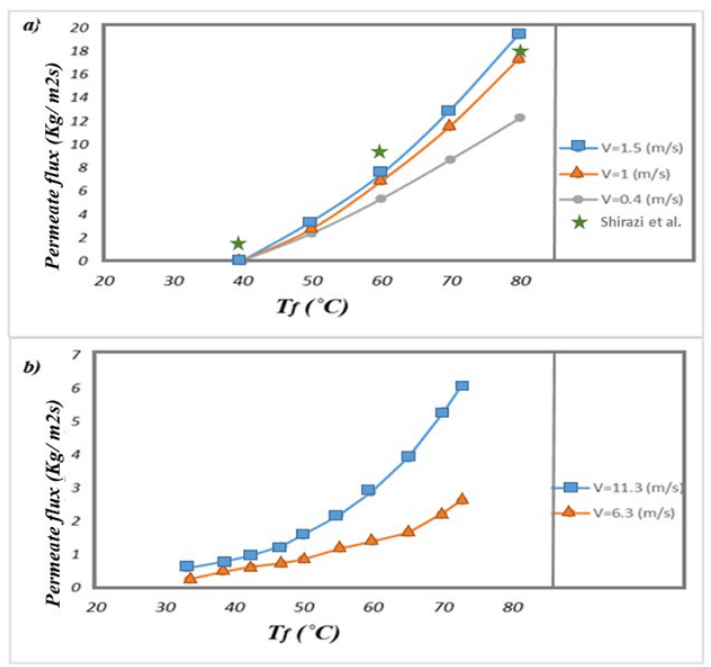
Fig. 5: The effect of feed temperature on permeate flux (a) in three different velocities (0.4,1,1.5 m/s), (b) in two different sweeping gas velocity (6.3,11.3 m/s) feed velocities = 0.1 m/s, temperature = 20 ˚C. (Flux is multiplied in 10- 3 )